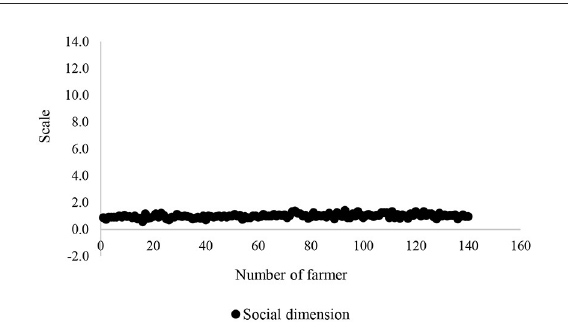
FIGURE7 Scatter of the social dimension of the agricultural sustainability of local farmers.